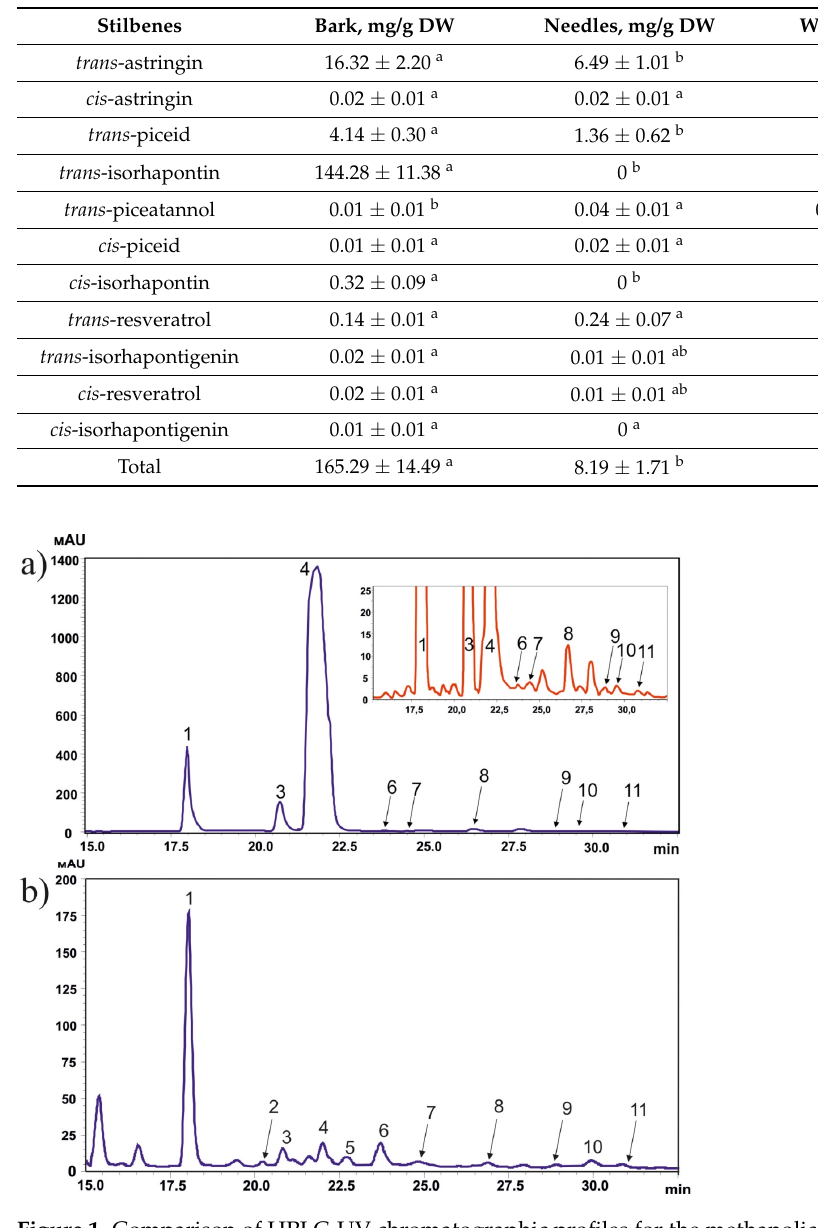
Table 1. Stilbene content and repertoire in the bark, wood, and needles of Picea jezoensis (mg per g of the dry weight (DW)) collected in winter. The data were obtained from a representative HPLC profile for the 96% ethanol extracts (60 ◦ C, 2 h) recorded at 310 nm. Means followed by the same letter (a, b, c, or ab) in one row were not different using Student’s t -test (three independent experiments). p < 0.05 was considered statistically significant.